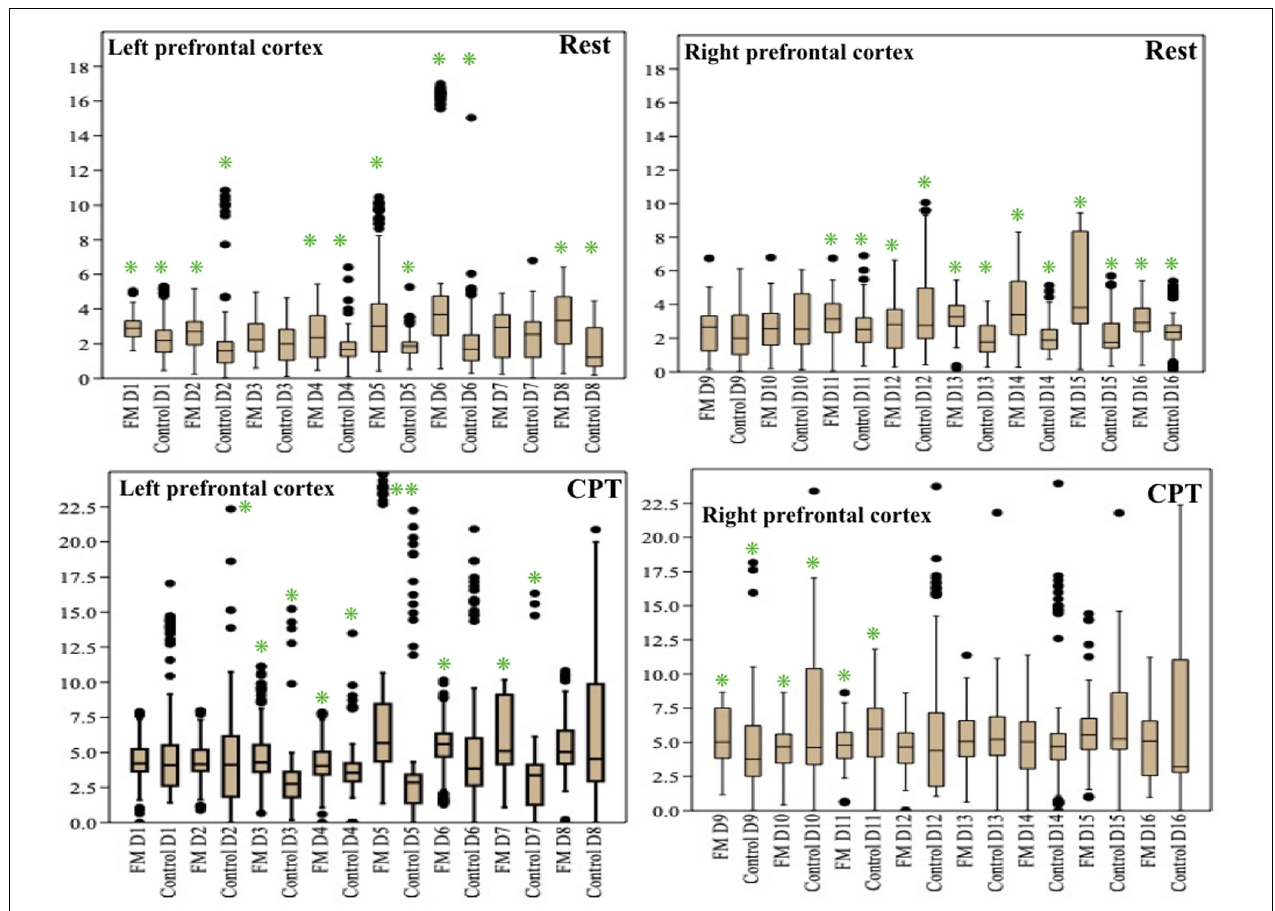
FIGURE 2 | Box-and-whisker plot for peak oxy-hemoglobin concentration ( µ M) recorded by functional near-infrared spectroscopy (fNIRS) detectors in the prefrontal cortex during rest and cold pressor test in fibromyalgia patients and control groups. Data are expressed as median with interquartile range. Statistics: Mann–Whitney U -test. * p < 0.05. CPT, cold pressor test; D, fNIRS detectors in the prefrontal